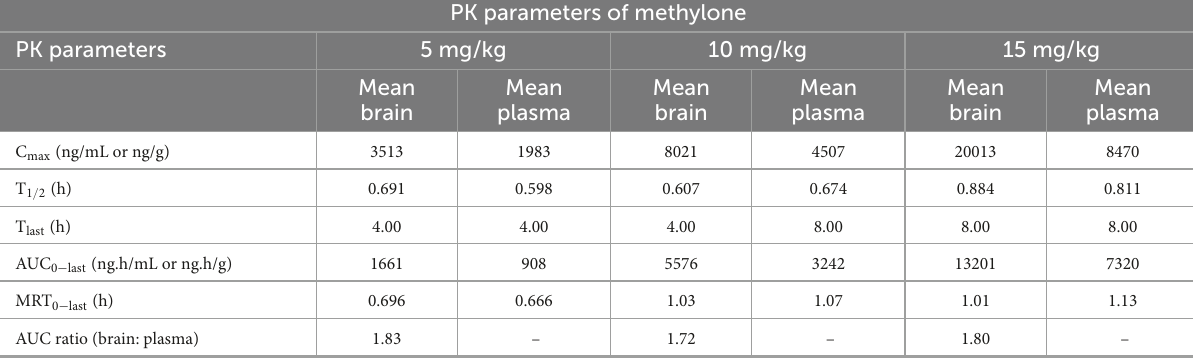
TABLE 1 Pharmacokinetic properties of methylone (5, 10, 15 mg/kg, IP) in rat brain and plasma. PK parameters of